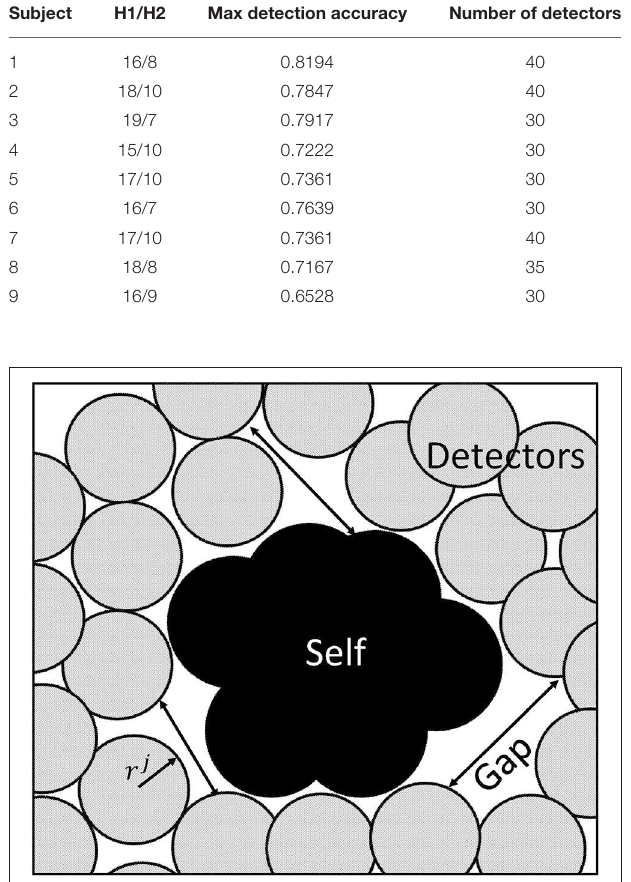
FIGURE 7 | Search space with self-samples and non-self